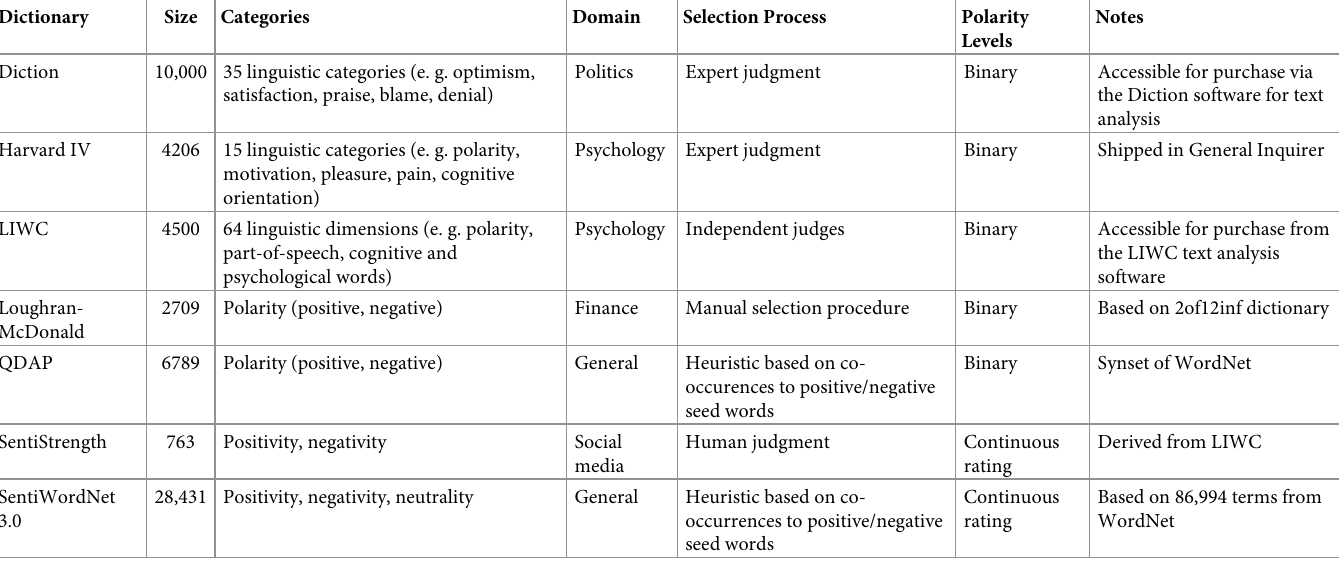
Table 1. Common dictionaries in behavioral